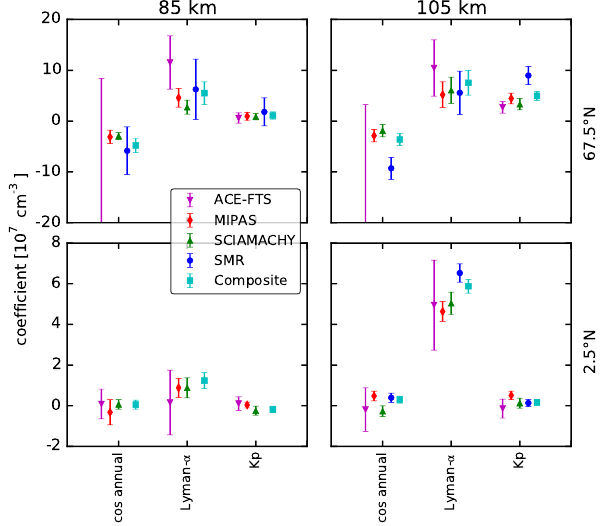
Figure 20. Direct comparison of the regression coefficients d 1 , b , and c at two altitudes (85km, left column; 105, right column) and two latitudes (67.5 ◦ N, upper row; 2.5 ◦ N, lower row). The error bars indicate the 95% confidence interval of the coefficient calcu- lated using the t